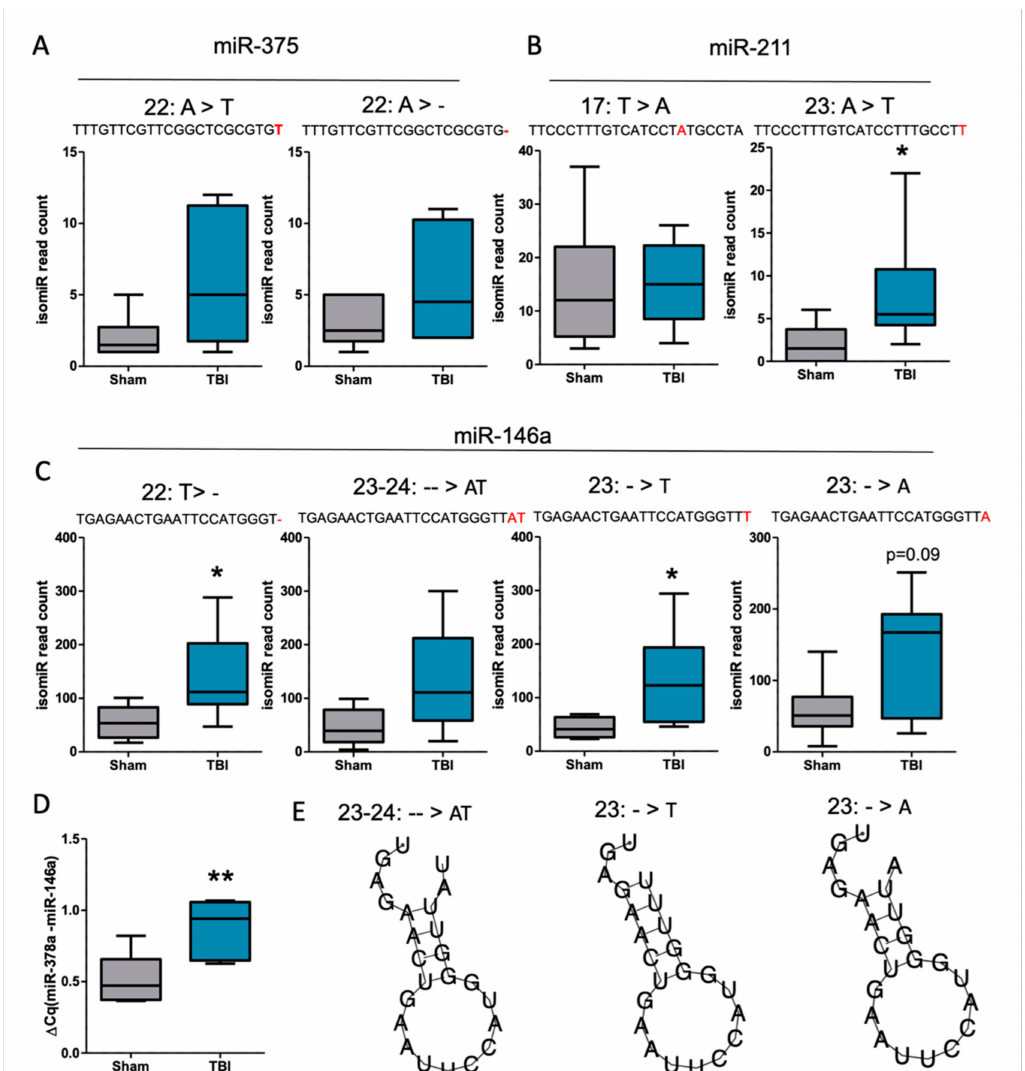
Figure 7. Analysis of isomiR types after traumatic brain injury (TBI). Analysis of cortical differentially expressed miRNAs revealed an increase, especially in 3 (cid:48) end modifications ( A , B ). The miR-211 isomiR 5 (cid:48) –TTCCCTTTGTCATCCTTTGCCTT was significantly increased after TBI (B, p < 0.05). For miR-146a, ( C ) several isomiRs were detected. These 2 isomiRs showed increased modifications at the 3 (cid:48) end (5 (cid:48) – TGAGAACTGAATTCCATGGGT- and 5 (cid:48) – TGAGAACTGAATTCCATGGGTTT; p < 0.05). Quantitative RT-PCR chemistry detecting all 3 (cid:48) end isomiRs ( D ) (FC = 1.7, p < 0.05) revealed a difference between controls and post-TBI animals. Primer assay targeting only canonical miR-146a did not detect this increase (see Supplementary Figure S3, FC = 1.4, p > 0.05). Interestingly, RNA folding assessment predicted the linear miR-146a form to change to a hairpin-like structure when insertions were detected in the miRNA 3 (cid:48) end ( E ). Statistical significance: *, p < 0.05; **, p <